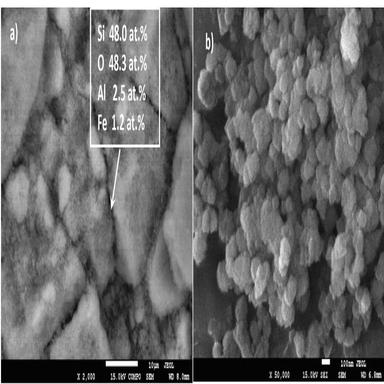
SEM images for Fe1.0HAlBEA (a-b) and Fe1.0SiBEA (c-d).